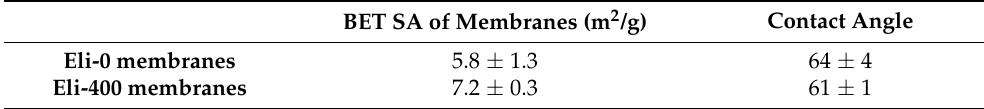
Table 3. BET surface area and contact angle of the membranes.